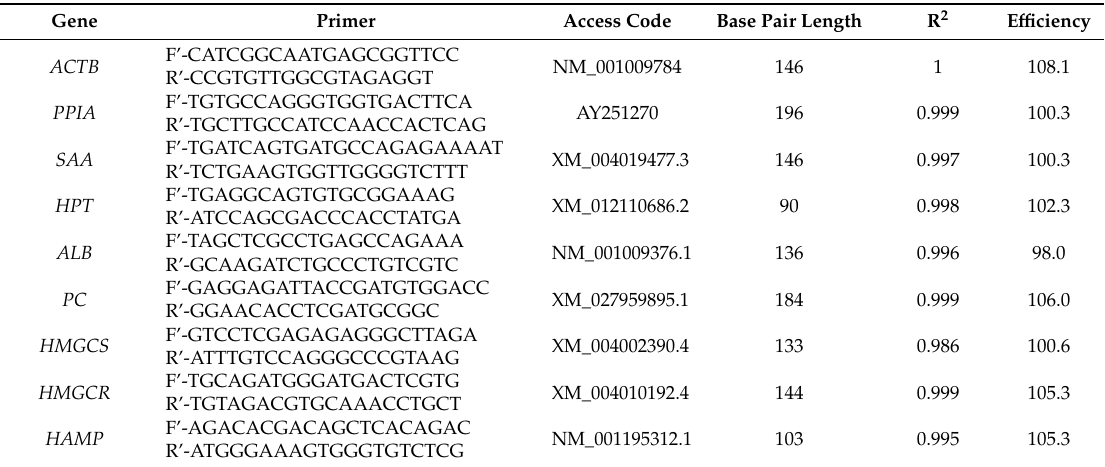
Table 2. Gene, primer sequence, access code, and base pair length according to NCBI, along with QPCR correlation and e ffi ciency.